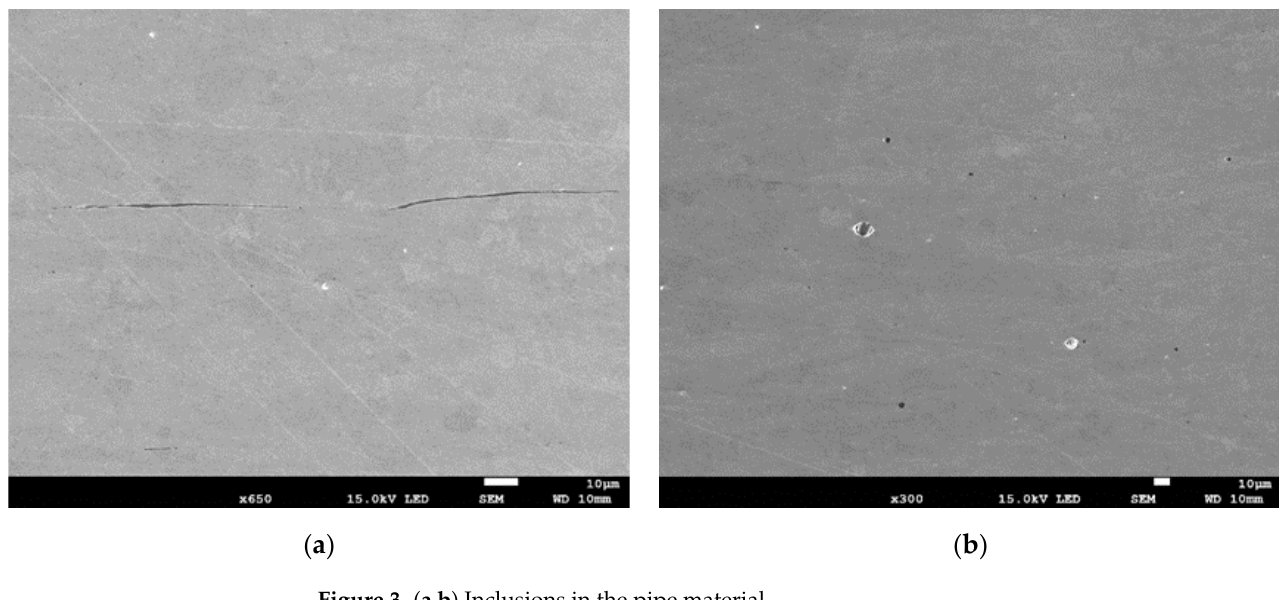
Figure 3. ( a , b ) Inclusions in the pipe material.